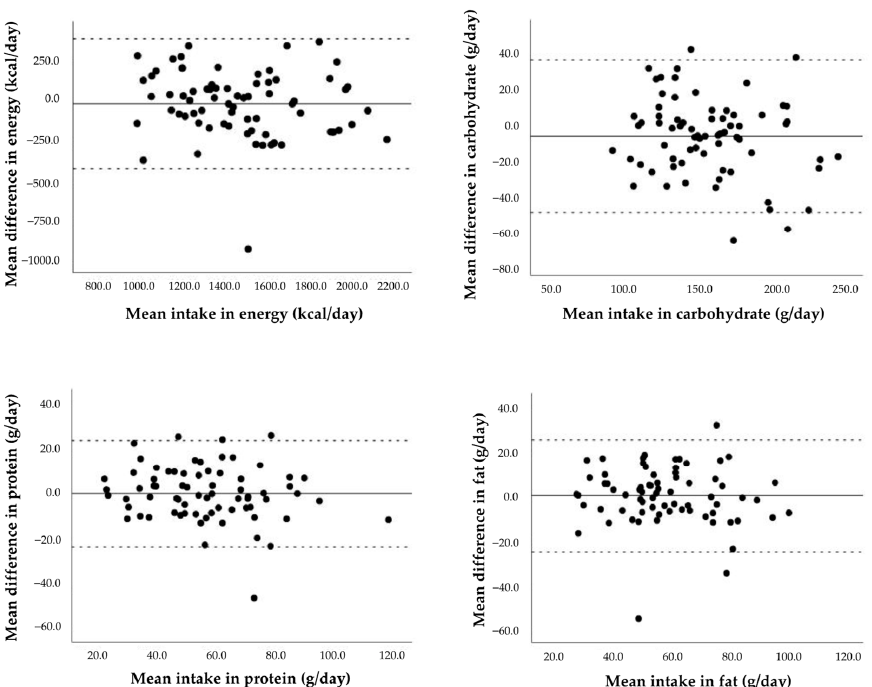
Figure 2. Bland–Altman plots showing the mean difference vs. the mean intake (solid line) between the test (Remind app) and reference (3-day handwritten food records) methods, and the lower and upper limits of agreement (dotted lines) for energy and macronutrient intake.